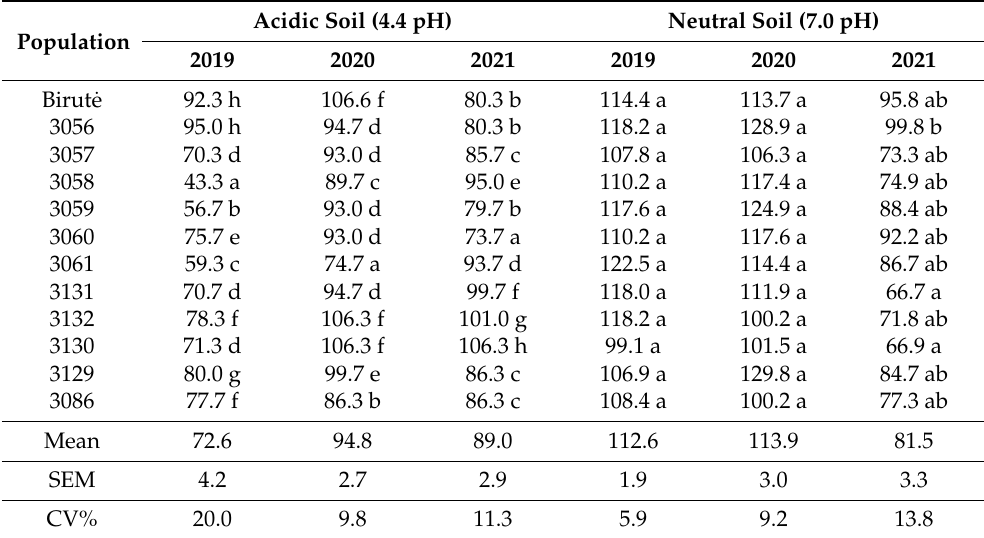
Table 4. The fresh matter yield (t ha –1 ) of alfalfa populations under different experimental sites (I and II). Acidic Soil (4.4 Population